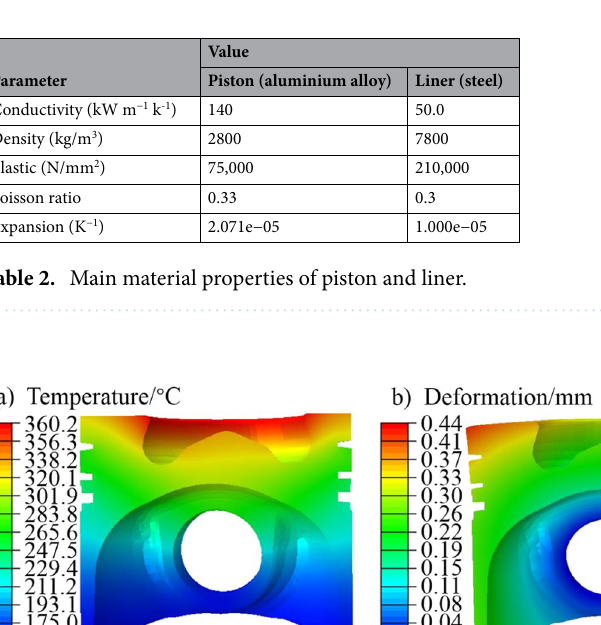
Figure 4. Isothermal distribution of piston and liner temperature field of ( a ) piston top surface, and ( b ) outer surface of the liner.